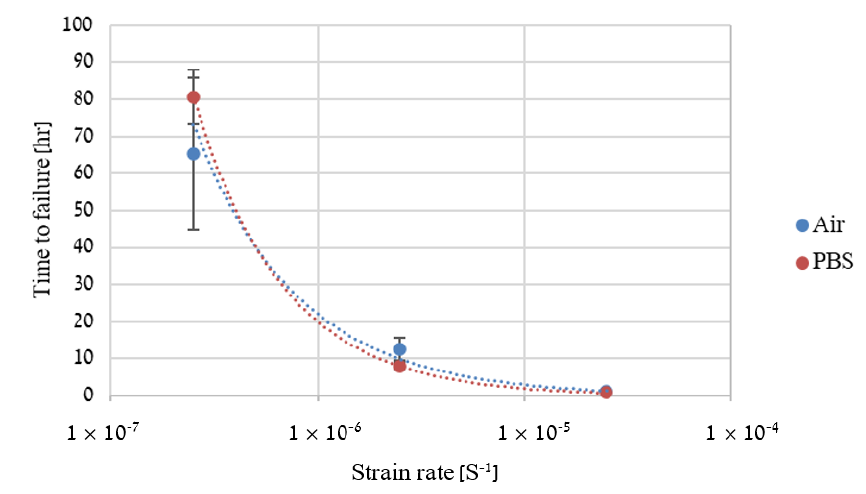
Figure 8. Time to failure vs. strain rate of Zn-2%Fe-0.6%Ca alloy in air and PBS solution.